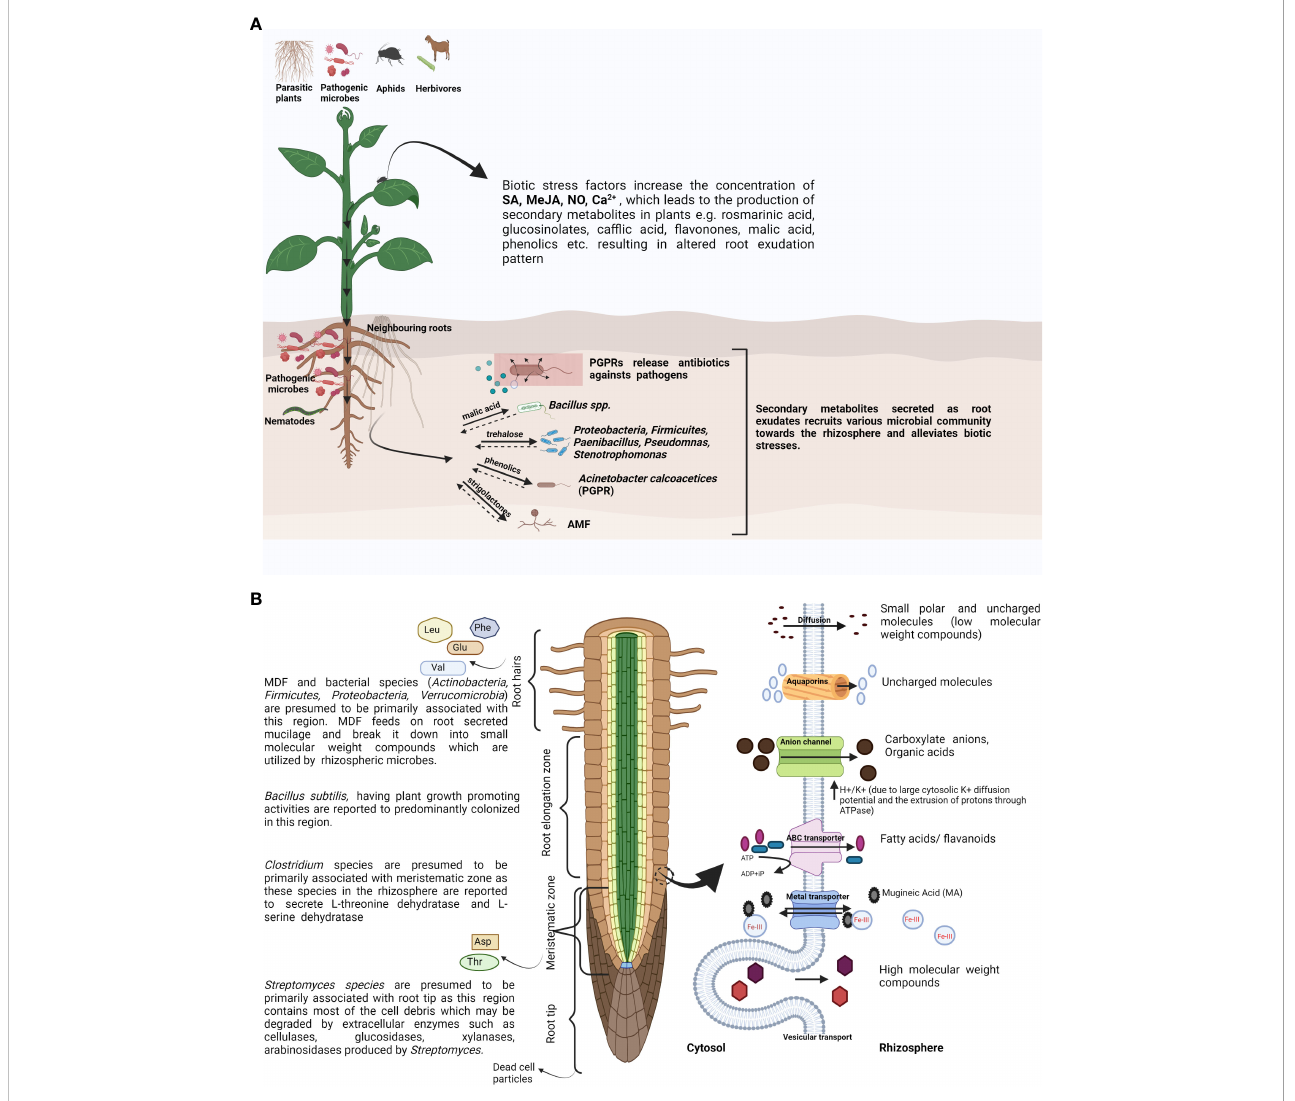
FIGURE 1 (A) Schematic representation showing the role of root exudates in altering rhizospheric microbial community composition sensing above-ground and below-ground biotic stresses. (B) Schematic representation of distinct root zones secreting varied blends of compounds along with the possible secretion processes across the plasma membrane into the rhizosphere. SA, salicylic acid; MeJA, methyl jasmonate; NO, nitric oxide; AMF, arbuscular mycorrhizal fungi; VOCs, volatile organic compounds; PGPR, plant growth-promoting rhizobacteria; Leu, leucine; Phe, phenylalanine; Glu, glutamic acid; Val, valine; Asp, aspartate; Thr, threonine; ABC transporter, ATP-binding cassette transporter. Created with